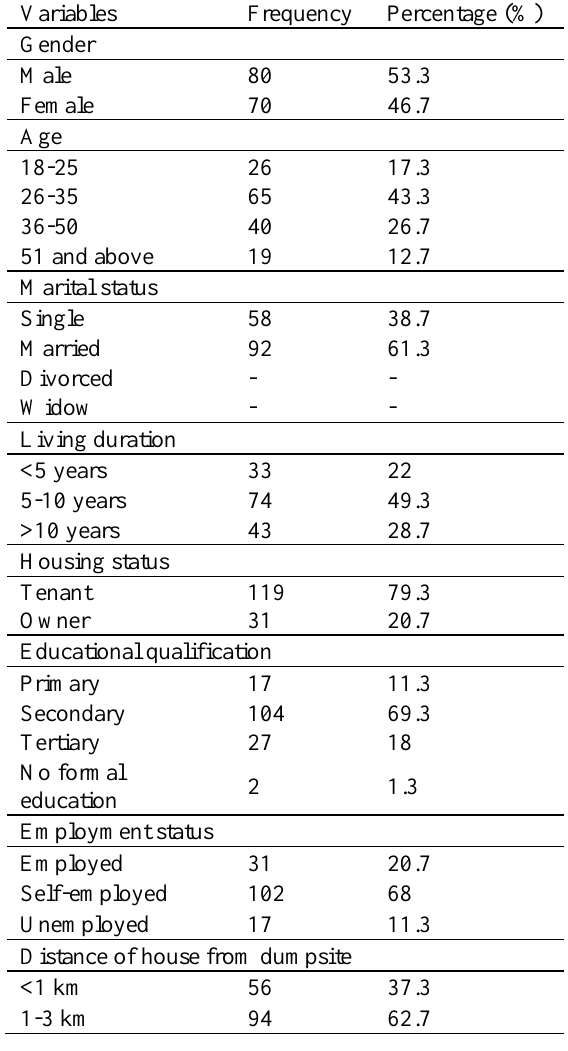
Table 1. Sociodemographic data of respondents living near dumpsite (n=150)